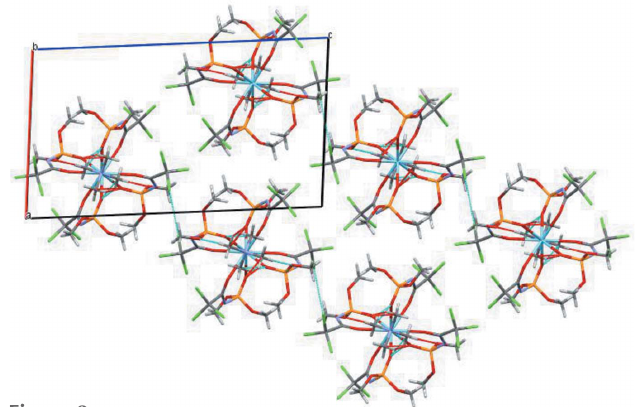
Figure 2 The crystal packing of the title compound viewed along the b -axis direction. , y , (cid:3) z + 1 2 2